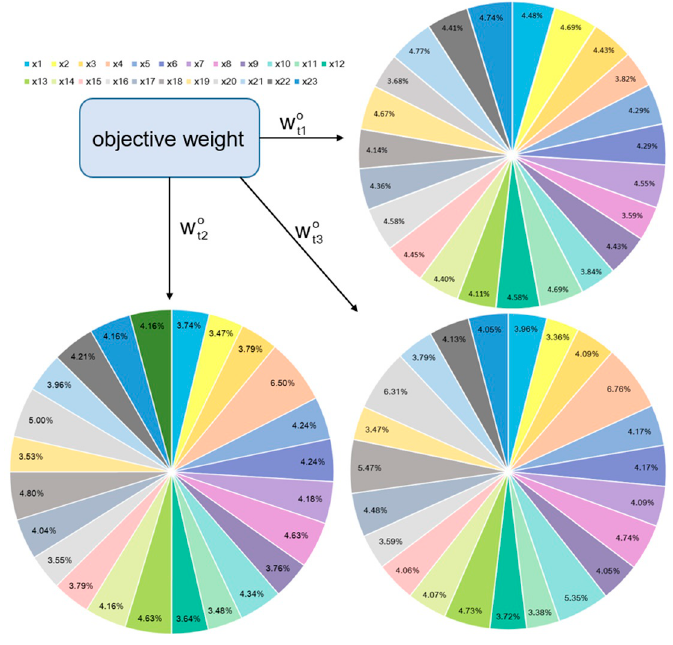
Figure 5. The objective weight ratio of the criteria.